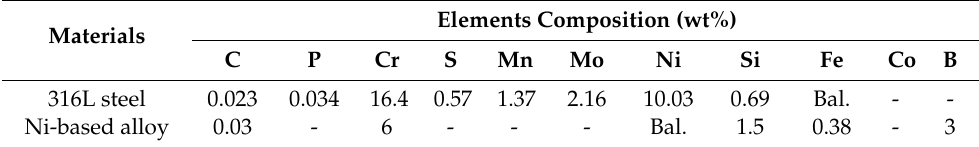
Figure 1. SEM image of Ni-based alloy powders. Table 1. Chemical composition of powder and substrate metal.